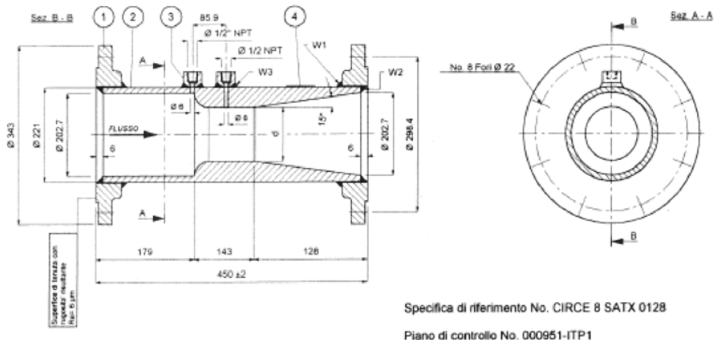
Figure 2: Venturi geometry CAD representation [7, 12].